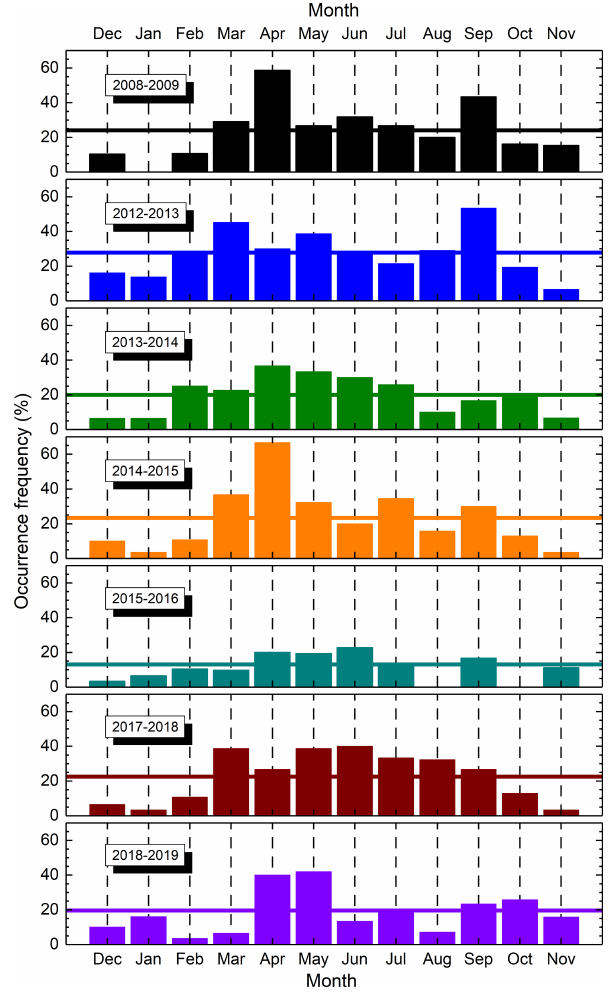
Figure 2. Distributions of the monthly mean relative occurrence fre- quency of NPF event days for the 7 measurement years. The hor- izontal lines indicate annual means. The value for January 2009 is zero, whereas the values for August and October 2016 are not available. The measurements in 2012–2013 were performed in the near-city background, whereas in the other years, they were accom- plished in the city centre.